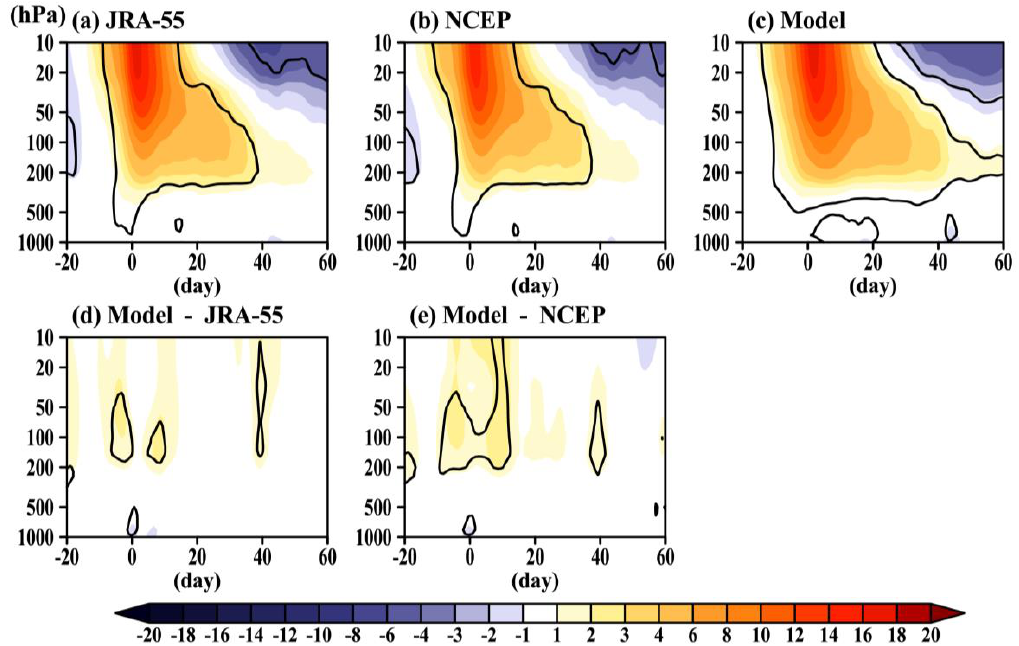
Figure 6. Same as in Figure 4, but for the polar cap temperature anomalies area-averaged over 60 – 90° N (shadings; units: K).